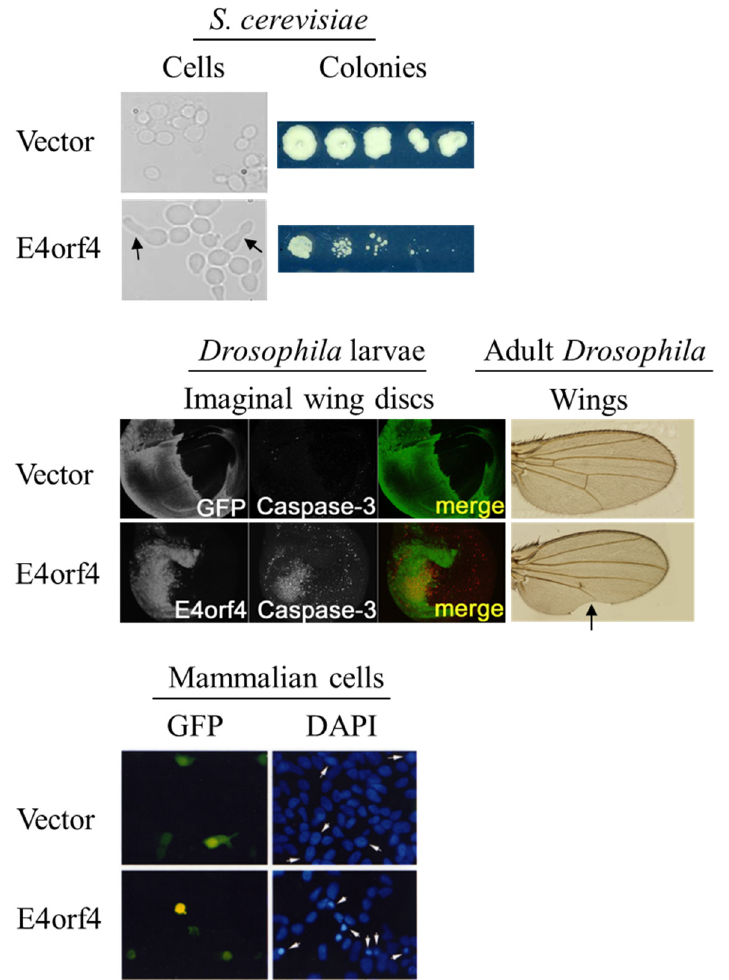
Figure 2. E4orf4-induced cell death is highly conserved in evolution. E4orf4-induced toxicity was studied in the yeast S. cerevisiae , in Drosophila melanogaster and in mammalian cells in tissue culture. The pictures shown here demonstrate E4orf4 effects in the various organisms, including budding defects in yeast (marked with arrows), reduced size of yeast colonies, caspase activation in a Drosophila wing disc, a wing defect in adult flies (marked with an arrow) and nuclear condensation seen by DAPI staining with cell rounding and blebbing seen by GFP staining in mammalian cells (arrows mark nuclei of transfected cells). E4orf4-induced toxicity required an interaction with PP2A in all these organisms and an interaction with Src kinases contributed to this process in flies and mammals. Studies of E4orf4 in all these model systems contributed different insights into E4orf4 biology. See the text for more details. Parts of this figure were adapted from the following sources with permissions: Top panel: [45]. Middle panel: [22]. Bottom panel: